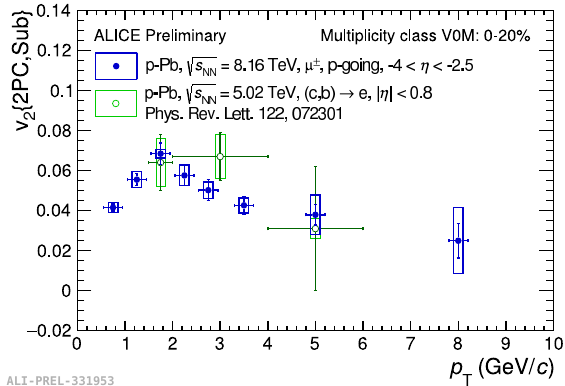
Figure 6: Elliptic flow of inclusive muons as a function of p (cid:112) = 8.16 TeV compared to the results for heavy-flavor hadron decay electrons at s NN (cid:112) = 5.02 TeV [ 15 ] s NN